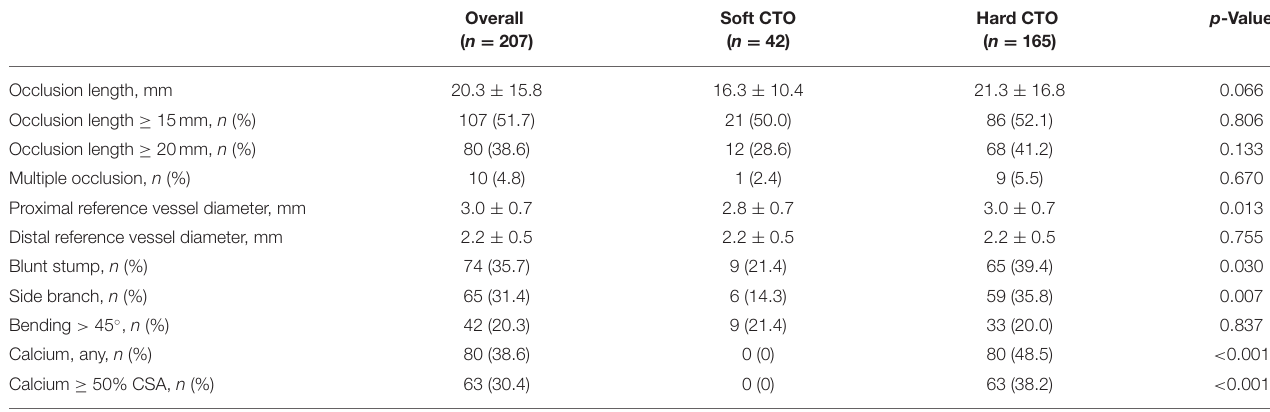
TABLE 3 | Computed tomographic characteristics.